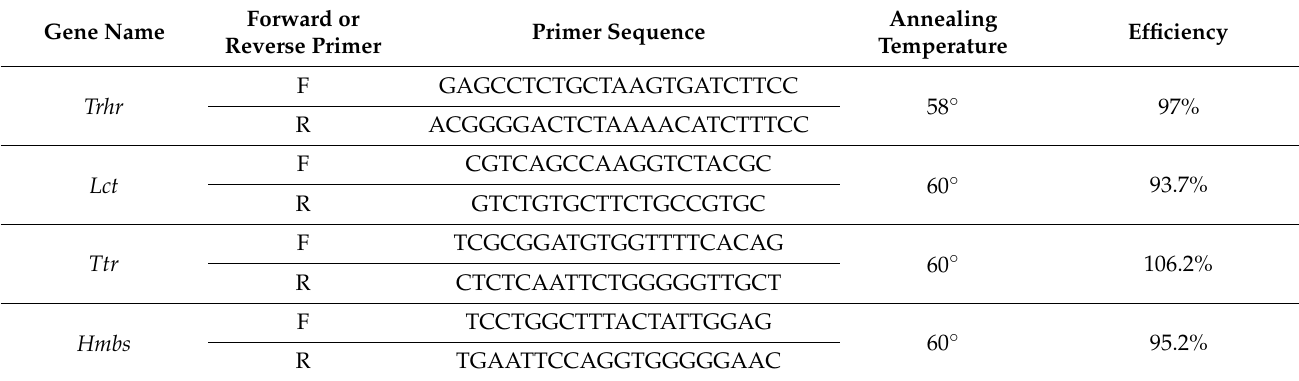
Table 1. Primers used for PCR validation of dissection precision.